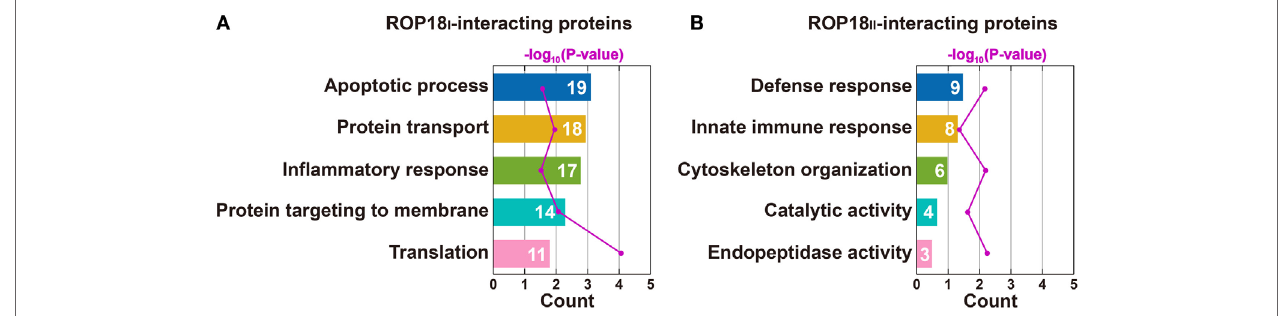
FigUre 4 | Top five enriched biological processes for ROP18 I (a) and ROP18 II -interacting proteins (B) identified by GO analysis. (a) ROP18 I -interacting proteins were significantly overrepresented in the biological processes of apoptotic process, protein transport, inflammatory response, protein targeting to membrane, and translation. (B) ROP18 II -interacting proteins were significantly overrepresented in the biological processes of defense response, innate immune response, cytoskeleton organization, catalytic activity, and endopeptidase